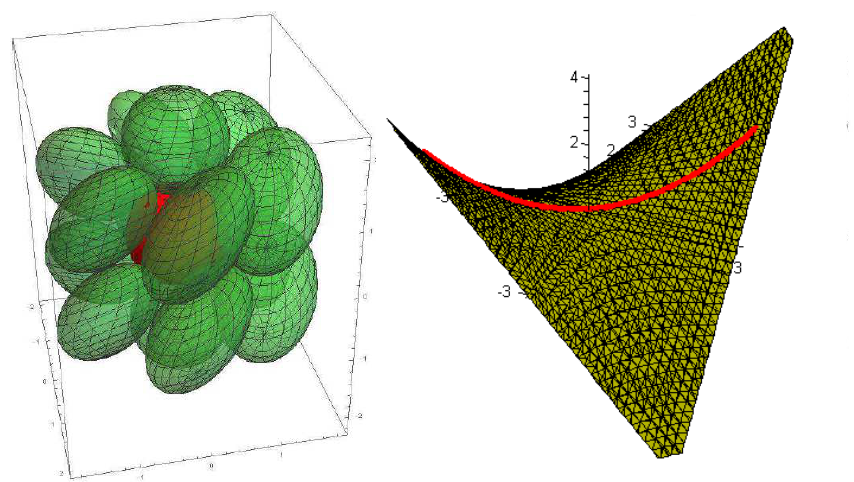
Figure 7. The densest lattice-like congruent ball configuration in Nil space related to the lattice parameter k = 1, the central red ball is touching 14 surrounding green ones (computer picture by Benedek Schultz), and a horizontal geodesic curve lying in a hyperbolic paraboloid.